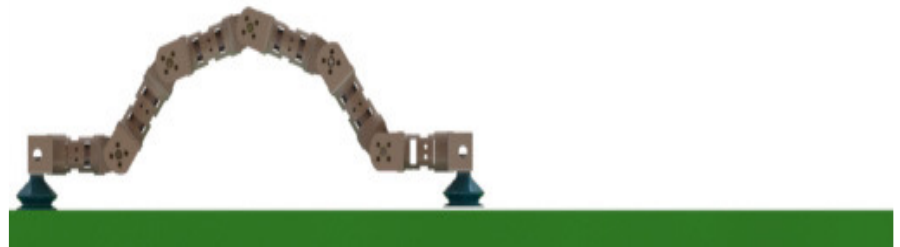
Figure 5. WBRD exported to simMechanics for